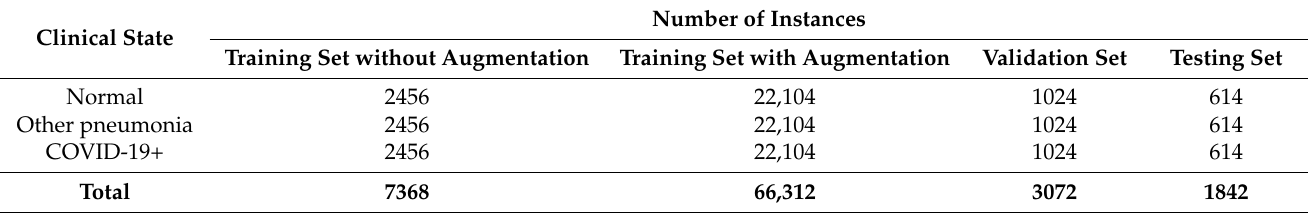
Table 2. Data set information.